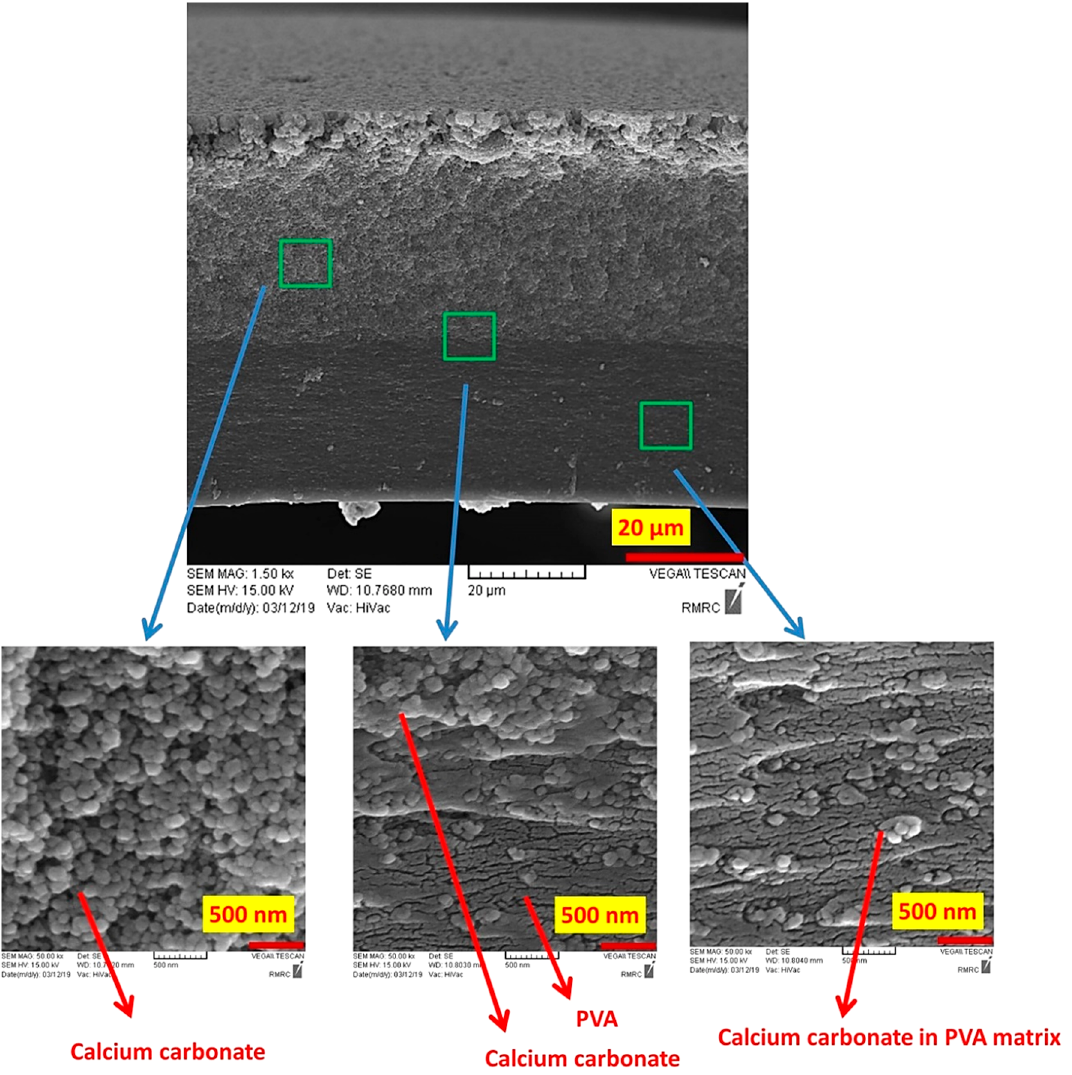
Figure 3. Scanning electron microscopy (SEM) images of PVA / CaCO 3 nanocomposites showing calcium carbonate rich and PVA-rich zones in the bilayer sample.